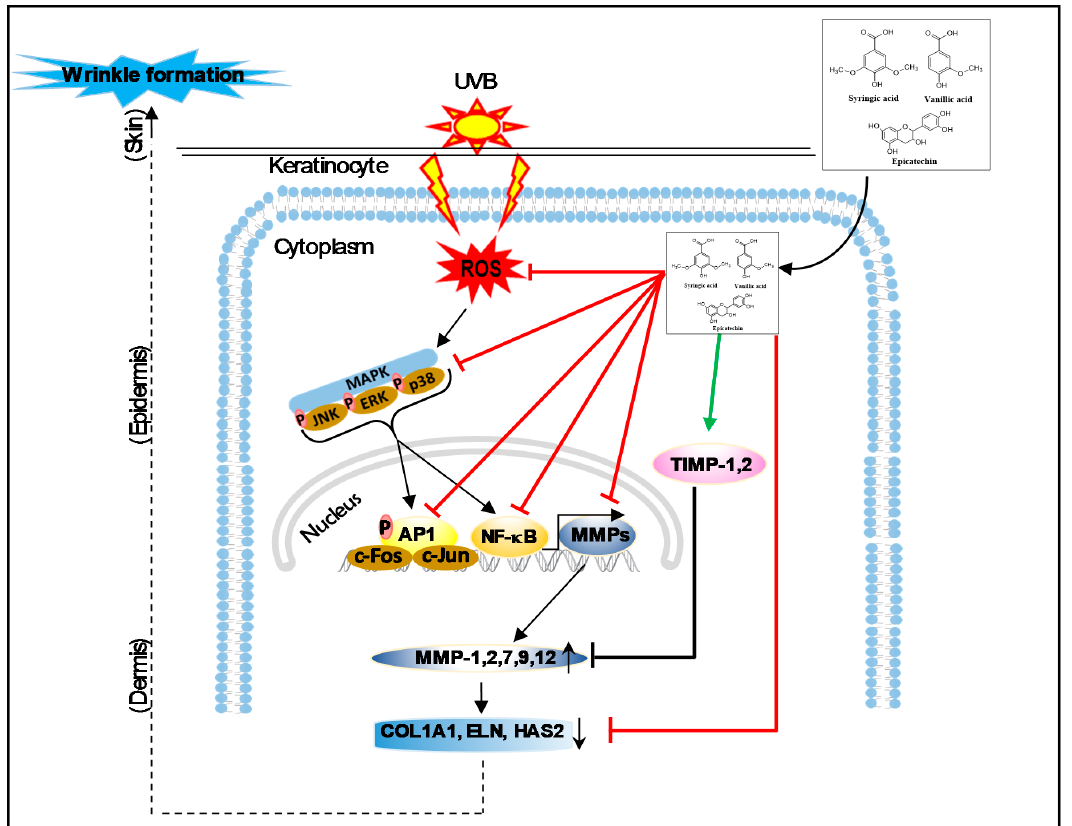
Figure 6. A proposed mechanism of SSE against UVB-induced photo-aging.